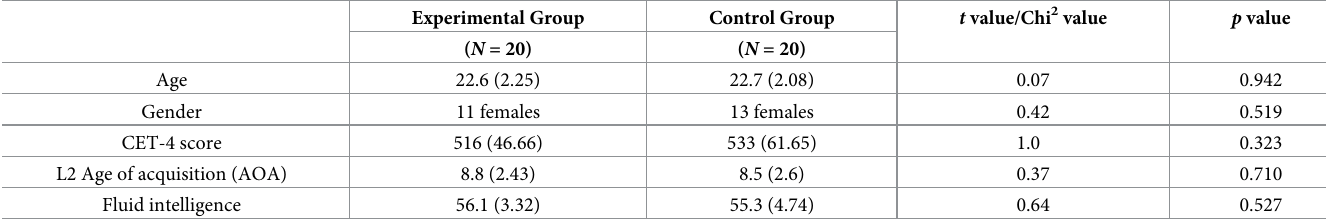
Table 1. Subject demographics. Means (standard deviations) of the subject demographics for the experimental and control